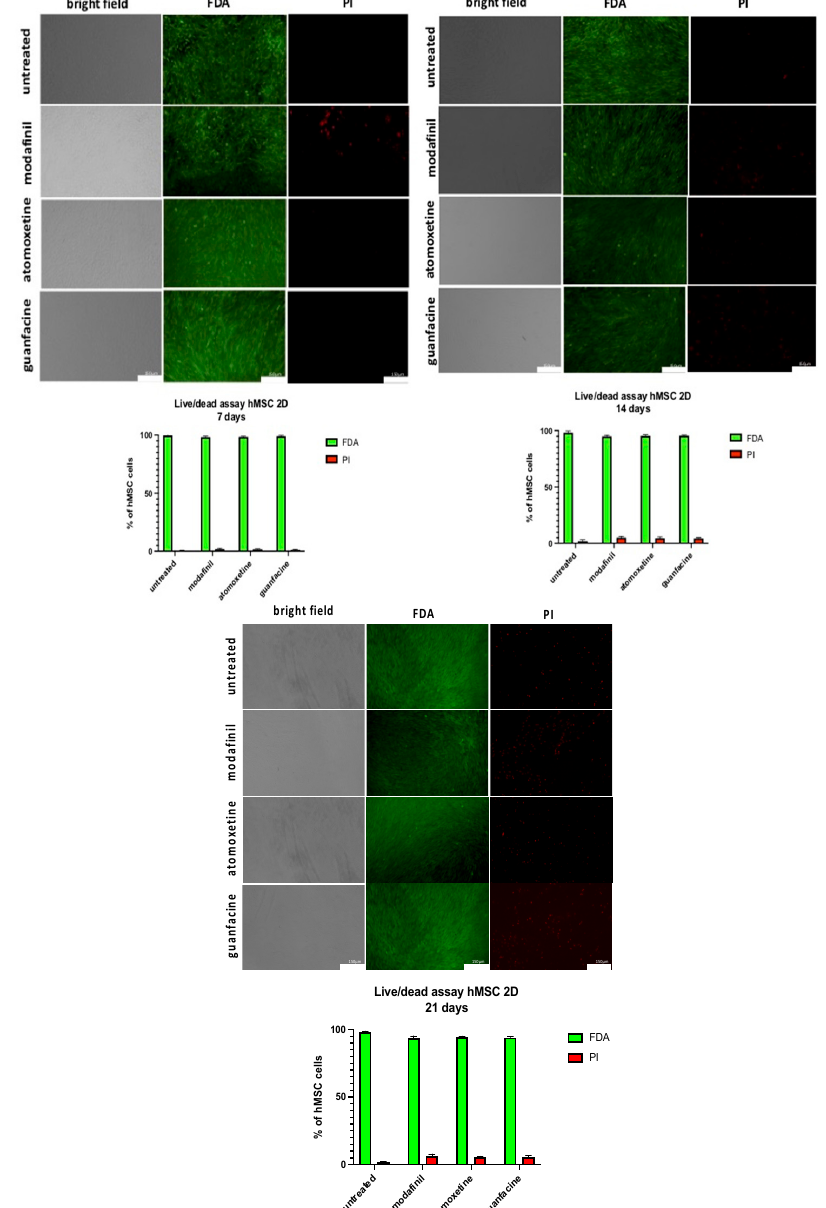
Figure 9. Cell viability assay of hMSC-monolayer, using a live/dead staining with FDA. (green, live cells) and PI (red, dead cells). Images represent 7, 14 and 21-day-old monolayer hMSC of untreated, modafinil- (11.2 µg/mL), atomoxetine- (0.9 µg/mL) and guanfacine- (17.7 ng/mL) treated cells. Shown are three independent experiments with six biological replicates. Densitometric quantification of viable (green) and nonviable (red) cells was calculated by ImageJ software. Significance in difference between the groups was determined by ANOVA followed by Tukey’s post hoc test. Scale bar 150 µ